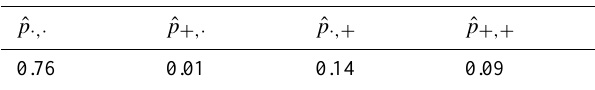
Table 3. Cosenza raingauge: estimated values of p · , · , p + , · , p · , + and p + , +